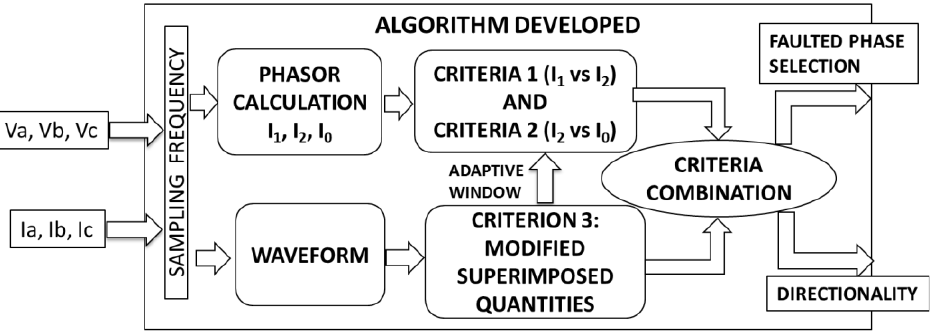
Figure 10. General diagram of the algorithm using multiple criteria and the adaptive window.